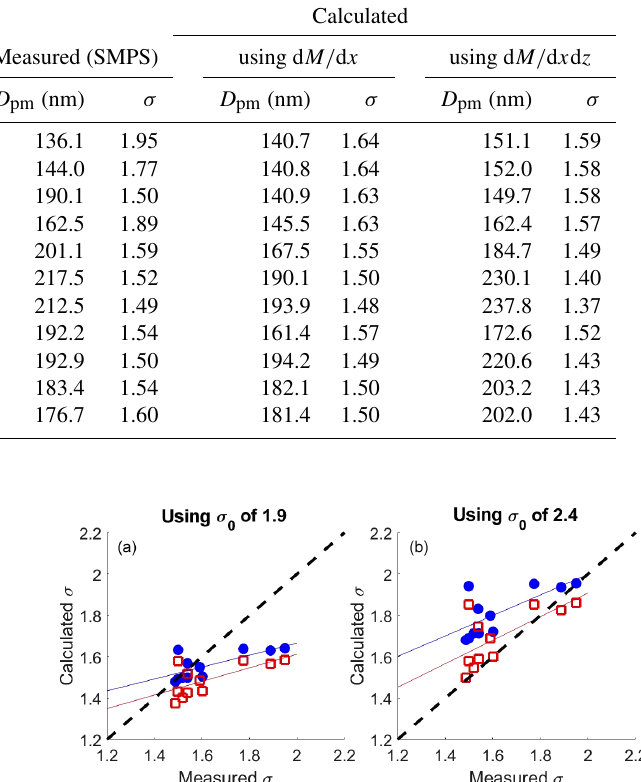
Table 4. Measured and calculated D pm and σ of biomass-burning plumes observed at MBO in August 2015. For the calculated D pm and σ , the initial size parameters used were D pm0 = 100nm and σ 0 = 1 . 9.